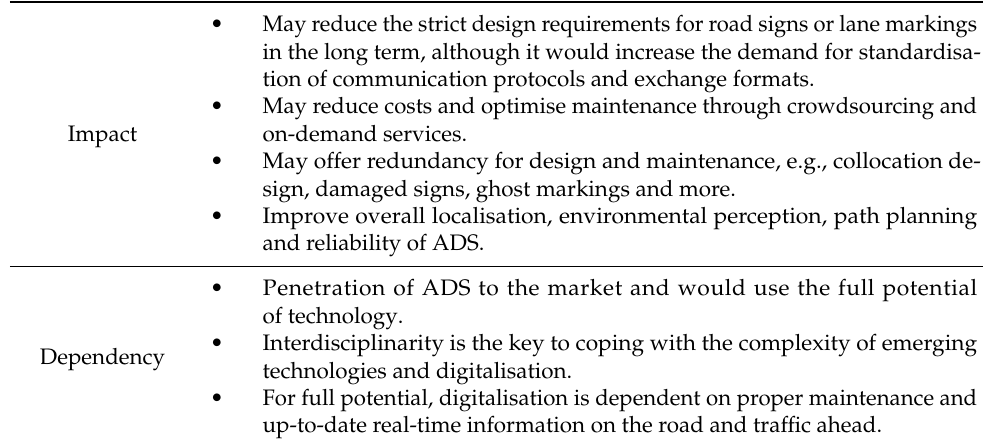
Table 12. Summary of impacts and dependencies of digitalisation.